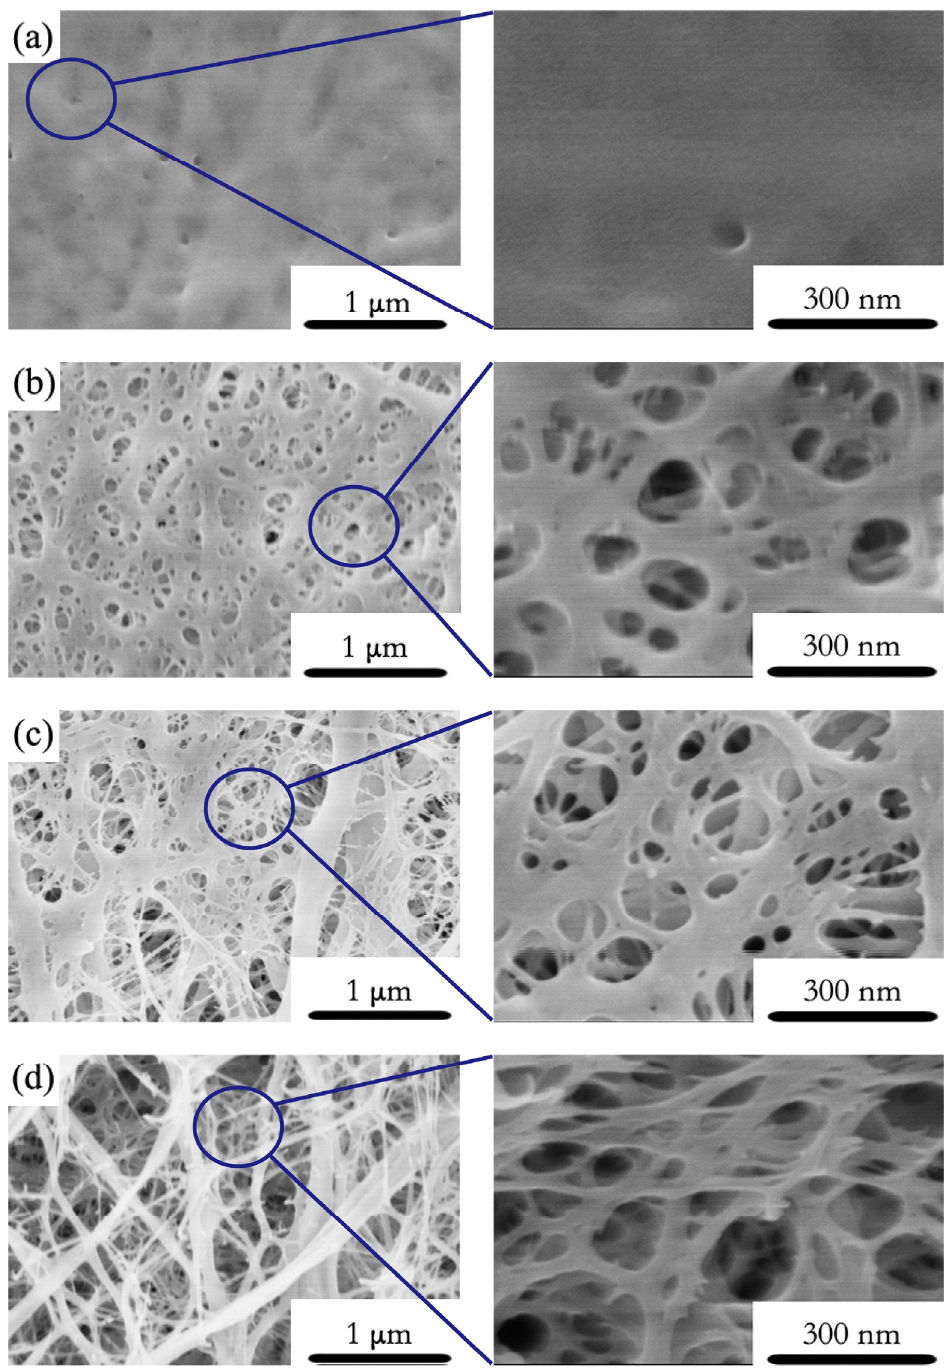
Figure 2. The SEM image of: ( a ) TOCNF-F; ( b ) TOCNF-E; ( c ) TOCNF-EF; ( d ) TOCNF-HEF at magnification of 30K ( left ) and 150K ( right ).